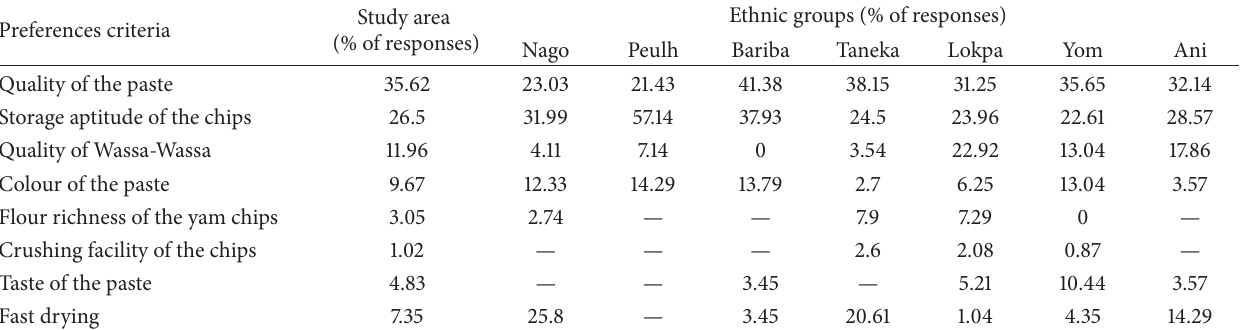
Table 8: Famer’s preference criteria of good kokoro yam cultivar for chips production in the study area and across ethnic groups. Preferences criteria Quality of the